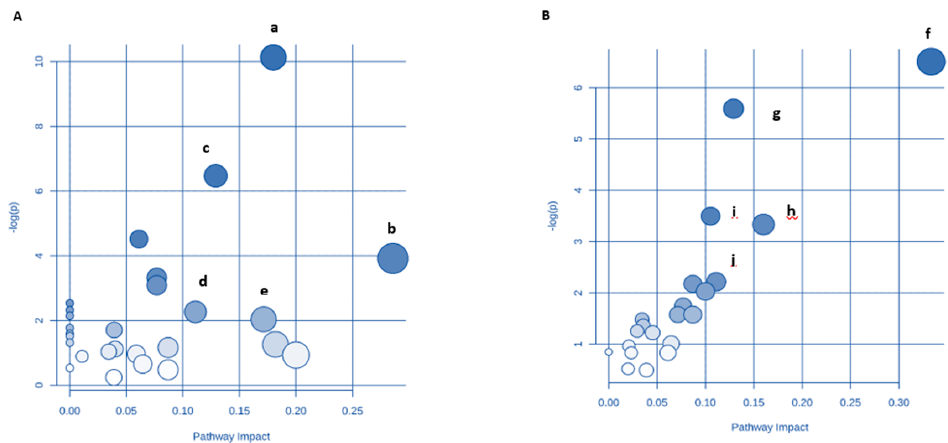
Figure 9. Potential pathways for the young probiotic group (YP) and aging probiotic group (AP), after DDS-1 supplementation, in fecal extracts identified using MetPA pathway analysis. YP group ( A ) with pathways (a) Valine, leucine, and isoleucine biosynthesis (b) Aminoacyl-tRNA biosynthesis (c) Glycine, serine, and threonine metabolism (d) Galactose metabolism (e) Cysteine and methionine metabolism. AP group ( B ) with pathways (f) D-Glutamine and D-glutamate metabolism (g) Alanine, aspartate, and glutamate metabolism (h) Galactose metabolism (i) Nitrogen metabolism (j) Butanoate metabolism.